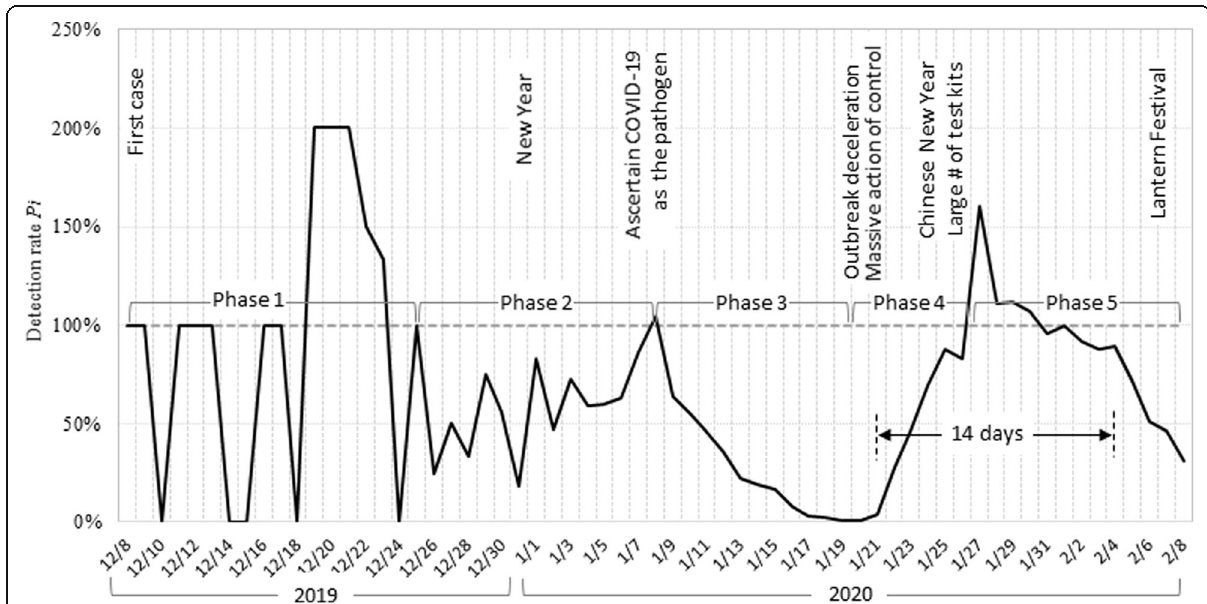
Fig. 3 Estimated daily detection rate Pi of COVID-19 (2019-nCoV) infection before, during and after declaration of the outbreak, the first 2 months of the Epidemic in